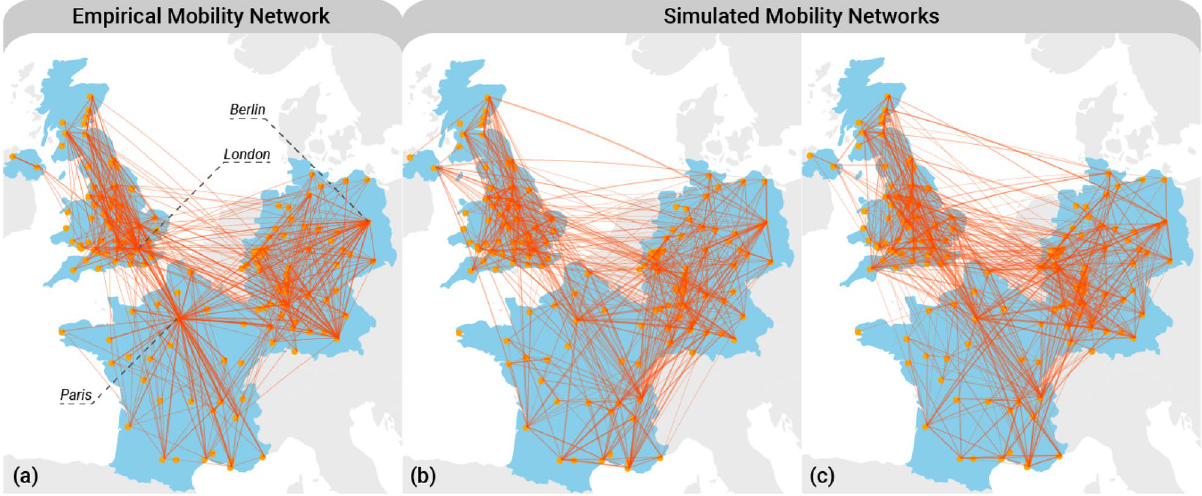
Figure 6. Empirical and Simulated mobility networks for France, Germany and UK. The empirical network ( a ) depicts the flows between cities as observed in the the period from 2000 to 2006. The thickness of the edges is proportional to the log of number of moves between the two cities. In ( b , c ) two realisations of the ABM are shown. In ( b , c ) 23,189 and 25,217 agents moving between 147 cities have been simulated, respectively. The difference in the number of agents is due to the stochastic entry and exit